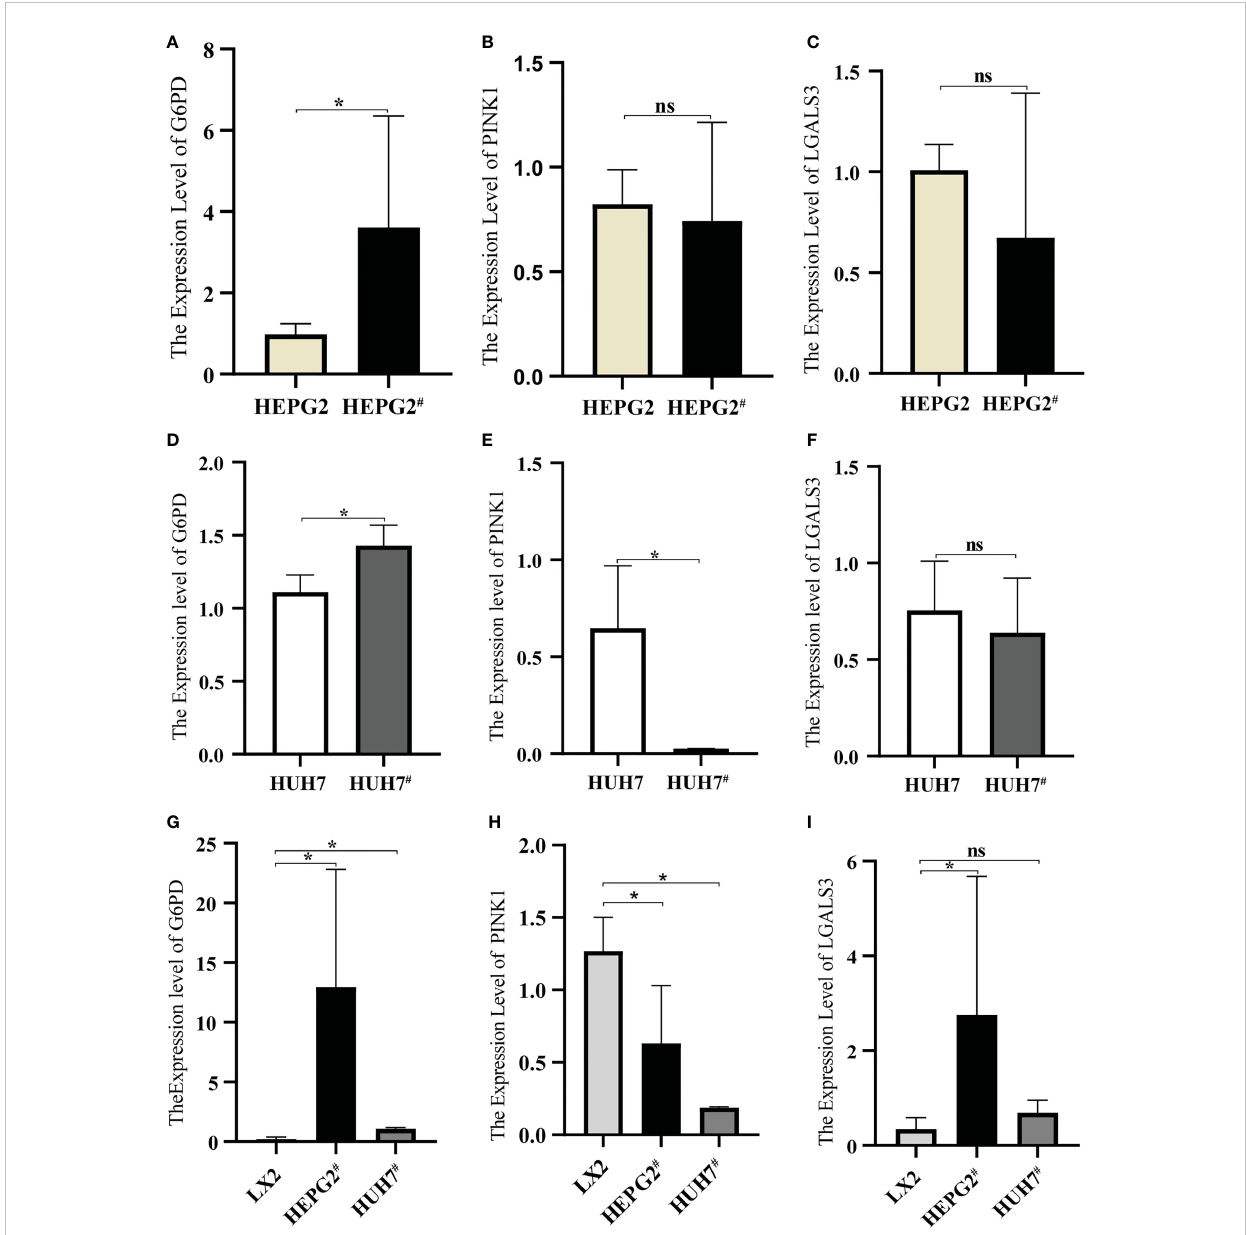
FIGURE 10 Expression of model genes in hepatocellular carcinoma cell lines. (A) Expression of G6PD in HEPG2 and HEPG2 # . (B) Expression of PINK1in HEPG2 and HEPG2 # . (C) Expression of LGALS3 in HEPG2 and HEPG2 # . (D) Expression of G6PD in HUH7 and HUH7 # . (E) Expression of PINK1in HUH7 and HUH7 # , (F) Expression of LGALS3 in HUH7 and HUH7 # . (G) Expression of G6PD in LX2, HEPG2 # and HUH7 # . (H) Expression of PINK1in LX2, HEPG2 # and HUH7 # . (I) Expression of LGALS3 in LX2, HEPG2 # and HUH7 # . * P < 0.05, ns, not signi fi